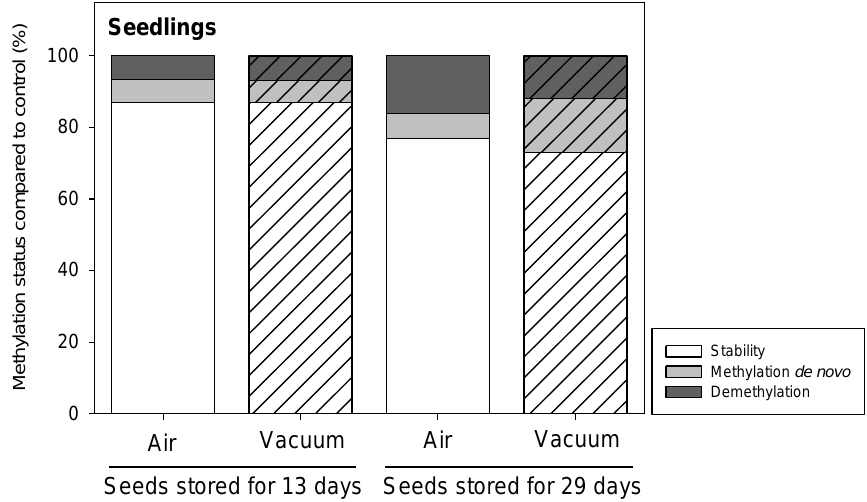
Figure 4. Percentage of stability and epigenetic changes detected in Secale cereale seedlings produced from seeds stored at 35 °C, 15% wc under two different storage atmospheres: air (filled bars) or vacuum (striped bars). DNA was isolated from two replicates of 10 seedlings per storage condition.